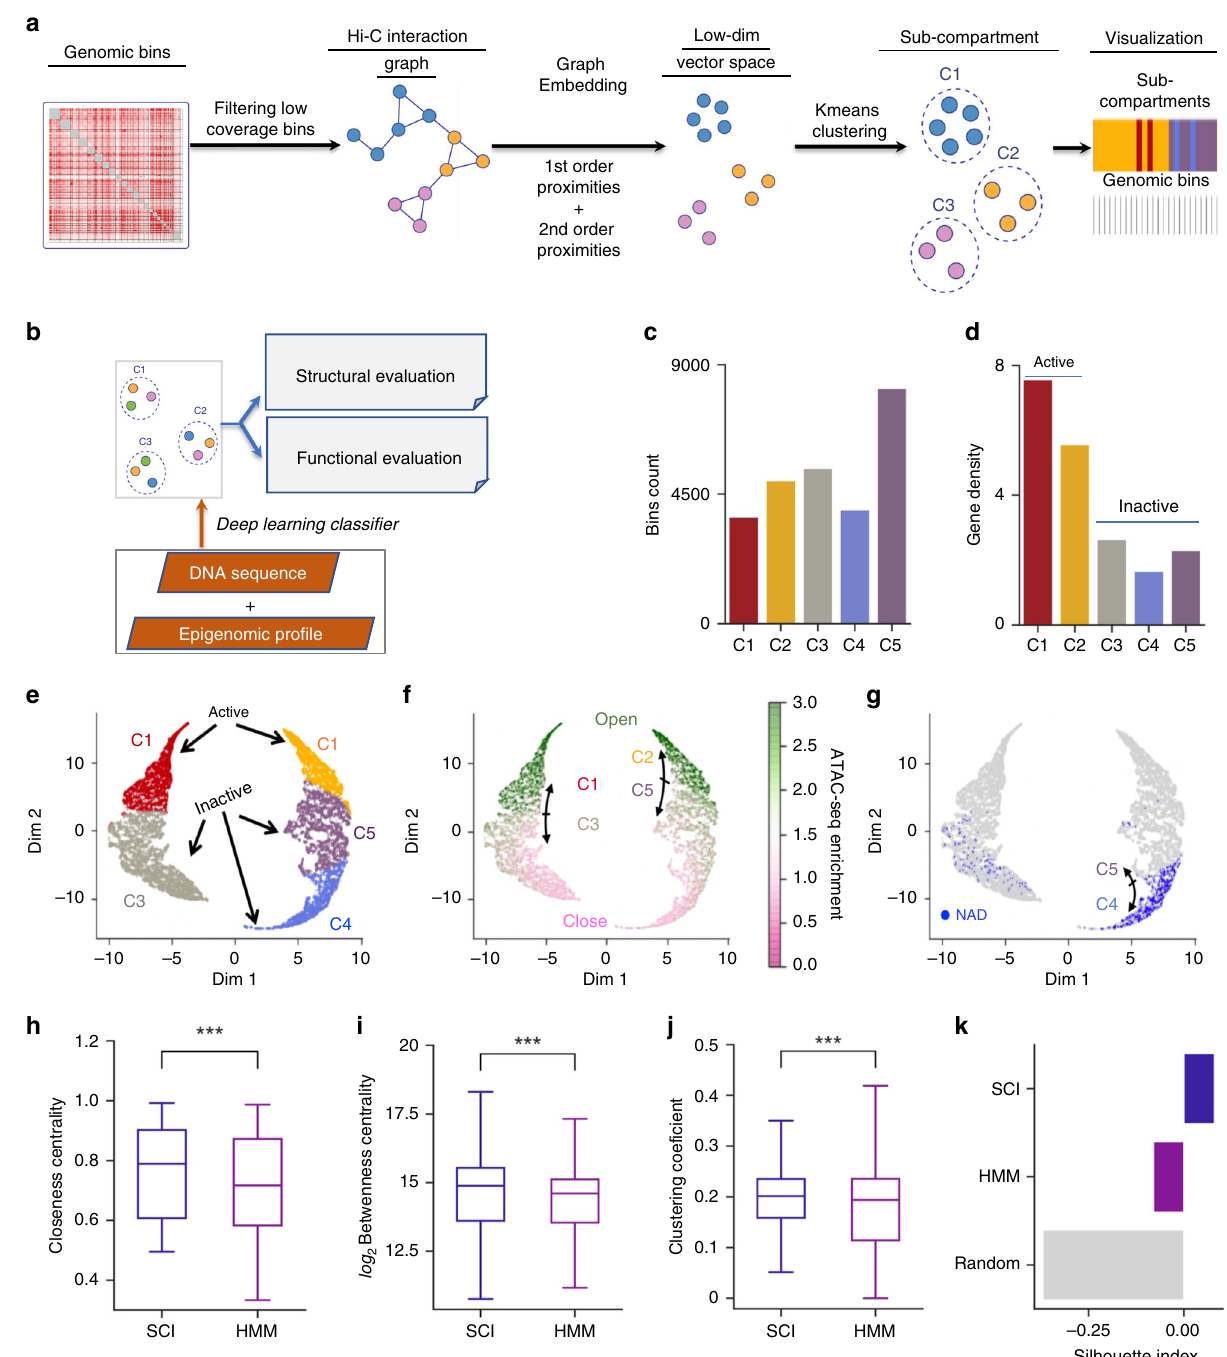
Fig. 1 SCI utilizes a chromatin interaction graph to predict genomic sub-compartments. a The SCI work fl ow starts with a normalized Hi-C inter- chromosome matrix. From this matrix, the interaction graph is constructed; nodes with the same color represent bins from the same chromosome. After building the interaction graph, the graph embedding step transforms the graph into a lower-dimensional space. Finally, k -means clustering is used to cluster node representations. b SCI-predicted sub-compartments are validated using structural and functional properties and serve as class labels to train a sub- compartment classi fi er based on a feature matrix compiled with features of DNA sequence and epigenomic pro fi les (methylation and histone modi fi cations), and replication timing data. c Bar plot of genomic bin count for each sub-compartment. d Bar plot of gene density measured as the number of genes per genomic bin for each sub-compartment. Sub-compartments associated with open chromatin (C1 and C2) show higher gene density compared to sub-compartments associated with closed chromatin (C3-C5). e UMAP 2-D projection of SCI ’ s embedding with 100 dimensions showing clustered sub- compartments for GM12878 Hi-C data. f ATAC-seq enrichment evaluating open and closed chromatin states across all fi ve sub-compartments. g Distribution of nucleolar-associating domains (NADs) between C4 and C5. h – k Comparison of clustering quality metrics between SCI and HMM: ( h ) closeness centrality, ( i ) betweenness centrality, ( j ) clustering coef fi cient and ( k ) Silhouette index. For the boxplots, the top and bottom lines of each box represent the 75th and 25th percentiles of the samples, respectively. The line inside each box represents the median of the samples. The upper and lower lines above and below the boxes are the whiskers. Asterisks (***) represent p -values < 2.2e − 16 using Mann – Whitney